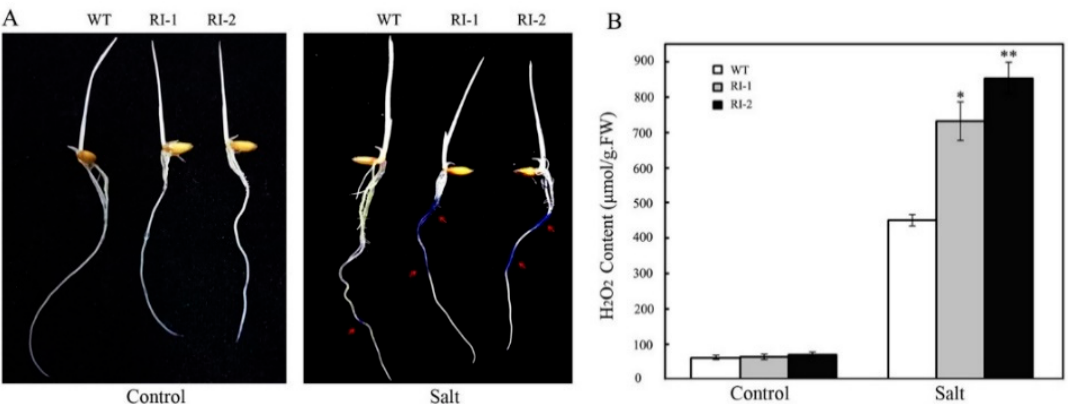
Figure 3. Inhibiting the expression of OsVTC1-3 impairs the ability of rice roots to scavenge ROS under salt stress. ( A ) The O 2 − content of OsVTC1-3 RI roots under salt treatment. The rice seedlings were treated with 150 mM NaCl for 1 h and then were stained with NBT to show the content of O 2 − in rice root. ( B ) The H 2 O 2 content of OsVTC1-3 RI lines under salt treatment. Control indicates that plants were grown under normal conditions, and NaCl indicates that plants were treated with 150 mM NaCl for five days. The arrow indicates the site where O 2 − were stained with NBT and showed a blue deposit. About 40–50 plants were used in each experiment. Bars represent SE ( ± ) of three independent assays, and the asterisk indicates that the results were significantly different from that of WT (** p < 0.01 and * p < 0.05). Significance was evaluated by the t -test.